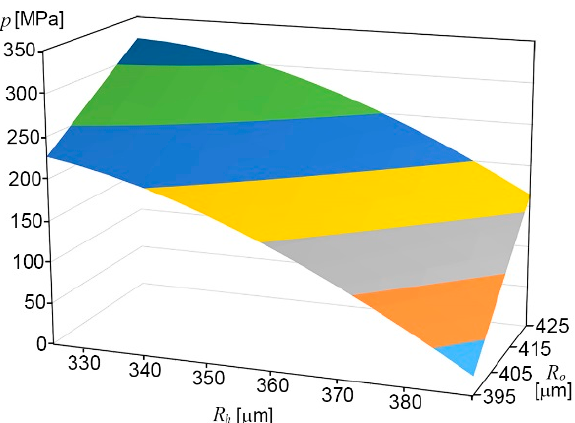
Figure 2. Interference pressure, p , as a function of R h of P polymethyl methacrylate (PMMA)-microhole, and R o of PEEK-capillary, for r i = 250 µm.